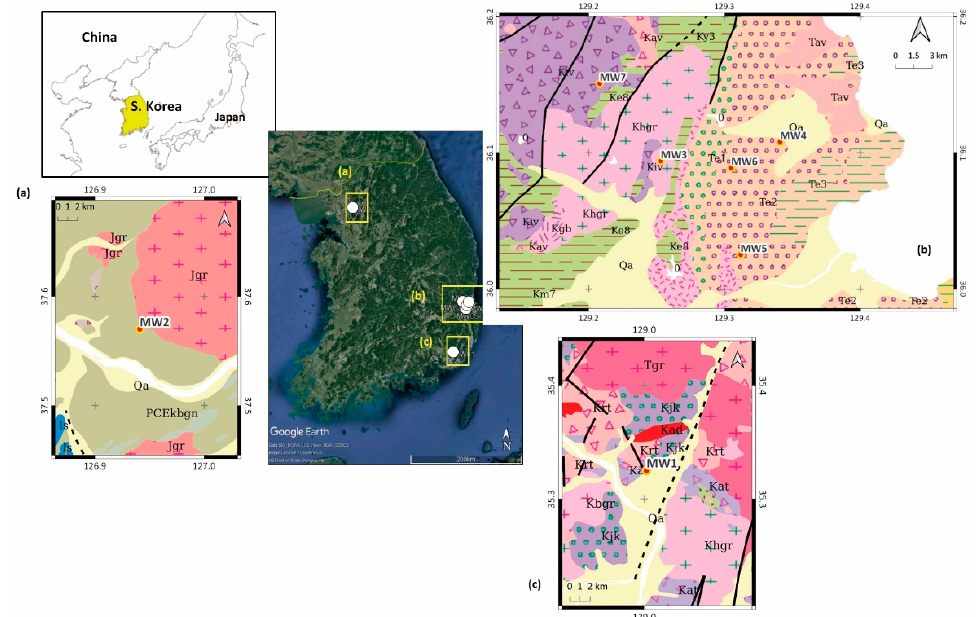
Figure 1. Location of groundwater monitoring stations in Korea with geological map. The subfigures are numbered along the latitude of well location: ( a ) MW2, ( b ) MW3-7, and ( c ) MW1. The yellow labels and boxes in the center map indicate the location of each subfigure. The map is based upon the digital geology map of 1M-scale by the Korean Institute of Geosciences and Mineral Resources through the web mapping service on OneGeology (http://onegeology-geonetwork.brgm.fr/geonetwork3/srv/eng/cata- log.search#/metadata/0fe907f345826b2f48455d1f26f94b26cc920241).